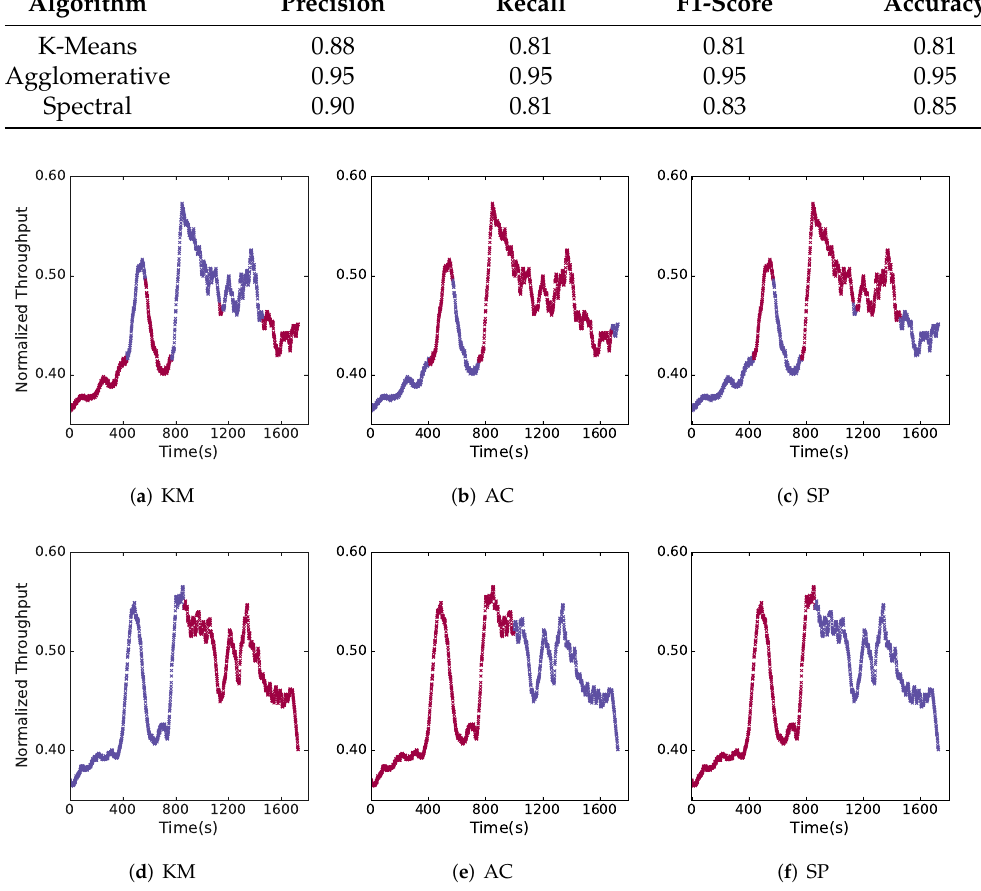
Figure 6. The result of state-mode identification by the algorithms in the algorithms set on the dataset with labeled cycles. The algorithms fail to capture the spatial dynamic to provide a baseline summary statistic for the identified states, top row; and with ordered data, only the temporal thresholds are identified, bottom